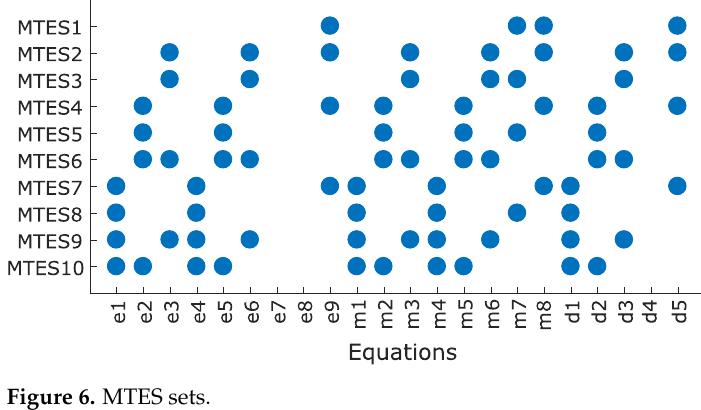
Figure 6. MTES sets.